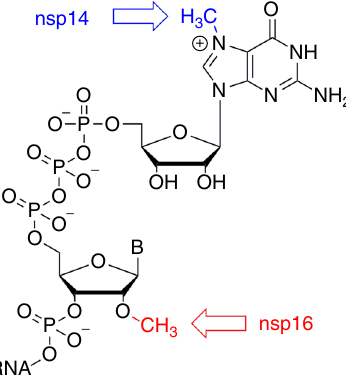
Fig. 1 RNA cap. Methylation performed by nsp14 is highlighted in blue, methylation performed by nsp16 in red. B =